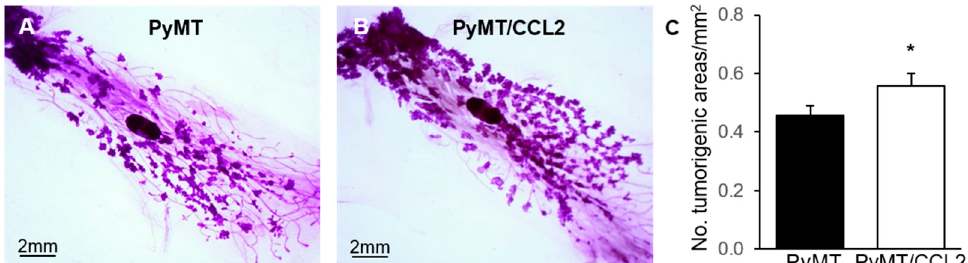
Figure 5. The effect of CCL2 overexpression on early mammary gland tumorigenesis in 9-week-old PyMT transgenic mice. Representative images of carmine alum stained whole mounted 4th pair mammary glands of 9-week-old ( A ) PyMT and ( B ) PyMT/CCL2 mice. ( C ) Tumorigenic areas were measured and analysed as number of tumorigenic areas per mm2 of gland. Data presented as mean + SEM ( n = 9 per group). Measured data were analysed using a simple linear regression, and number of tumours was analysed using a negative binomial regression with Wald Chi-square post hoc comparison. Statistical significance is indicated by * when p < 0.05.